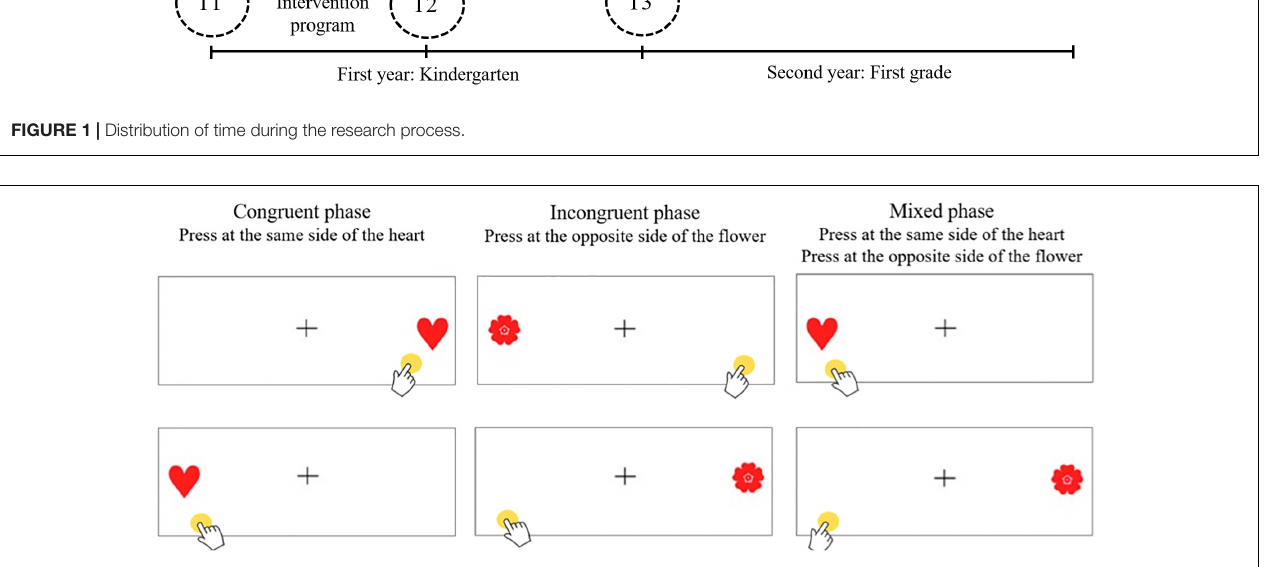
FIGURE 2 | Examples of the Hearts and Flowers test items at different phases.